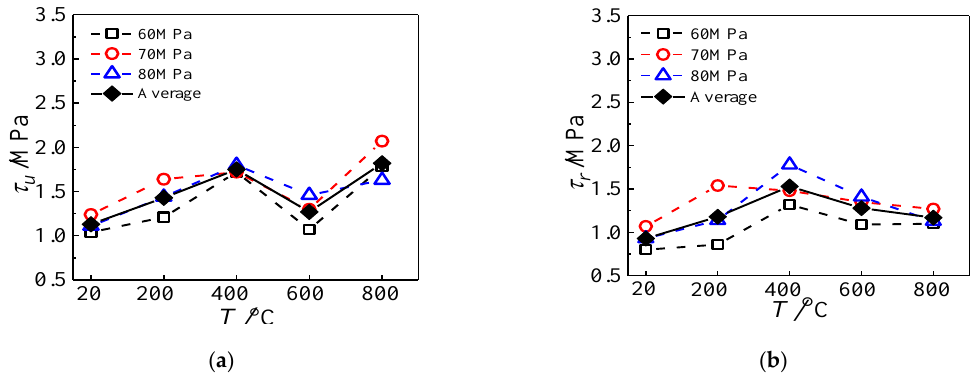
Figure 15. The effect of maximum temperature on bond strength ( a ) ultimate bond strength; ( b ) residual bond strength.